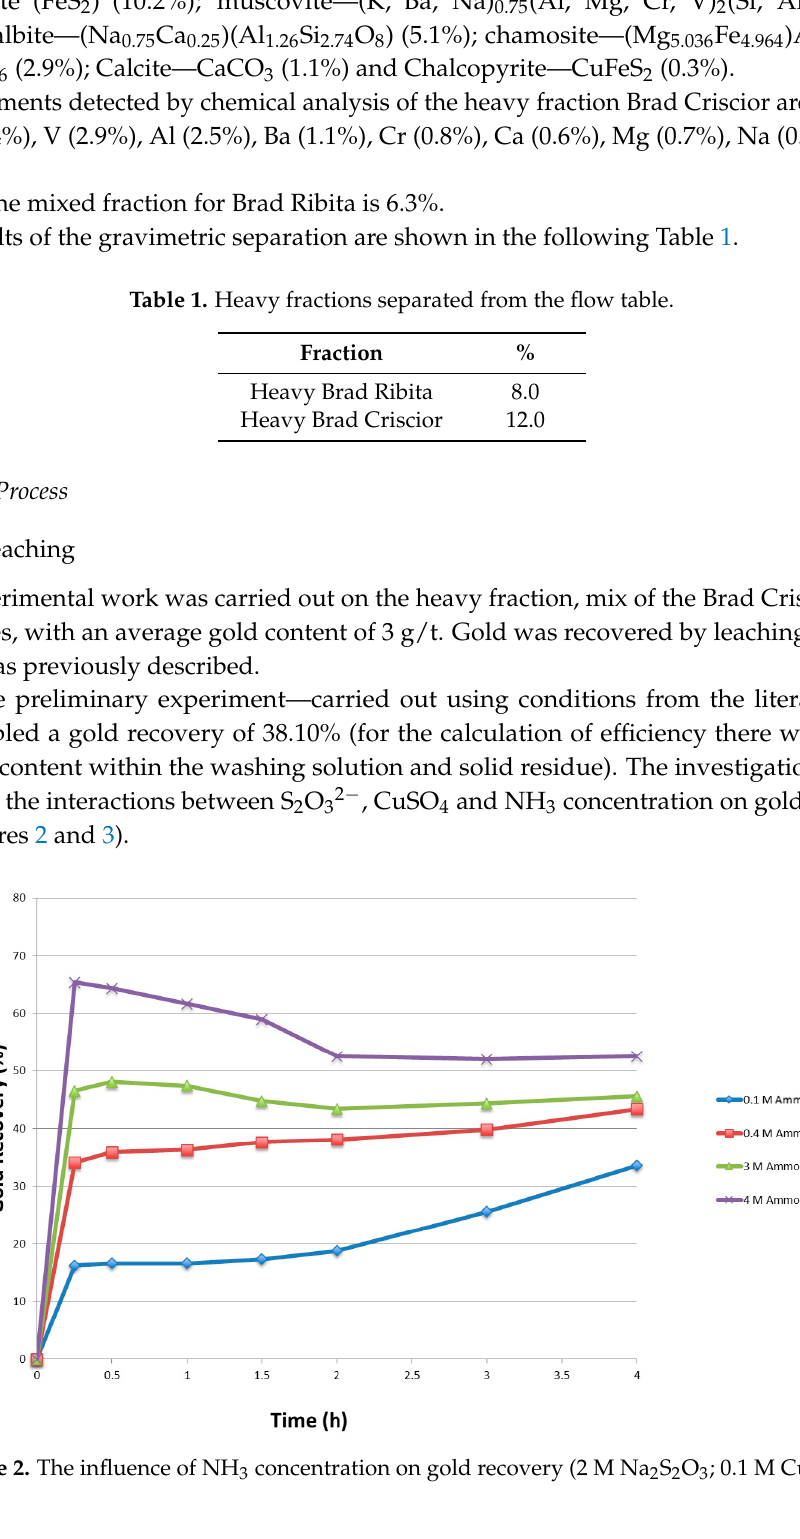
Table 1. Heavy fractions separated from the flow table.